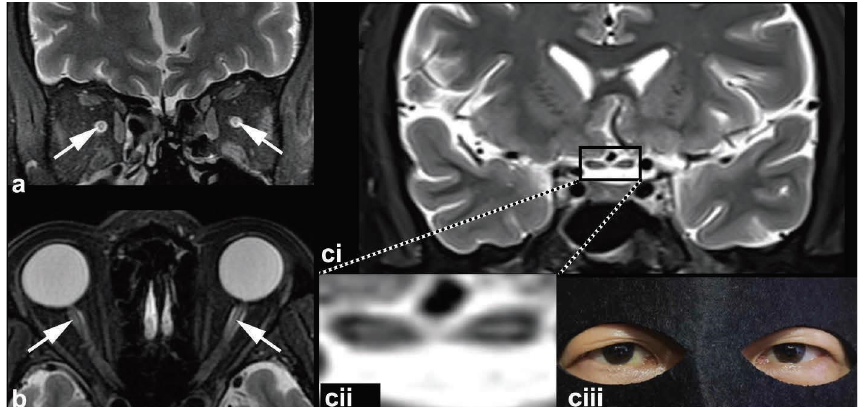
Figure 2: MRI identifed characteristic central hyperintense T2 signals in patients with methanol-induced optic neuropathy. (a) Coronal T2 image of patient 3, demonstrating hyperintense signals (arrows) in both orbital optic nerves as “target sign.” (b) Axial T2 image of patient 6, demonstrating hyperintense signals (arrows) in both orbital optic nerves as “neutral axis sign.” (c) (i, ii) Coronal T2 image of patient 4, demonstrating hyperintense signals in both cranial optic nerves as “mask sign”